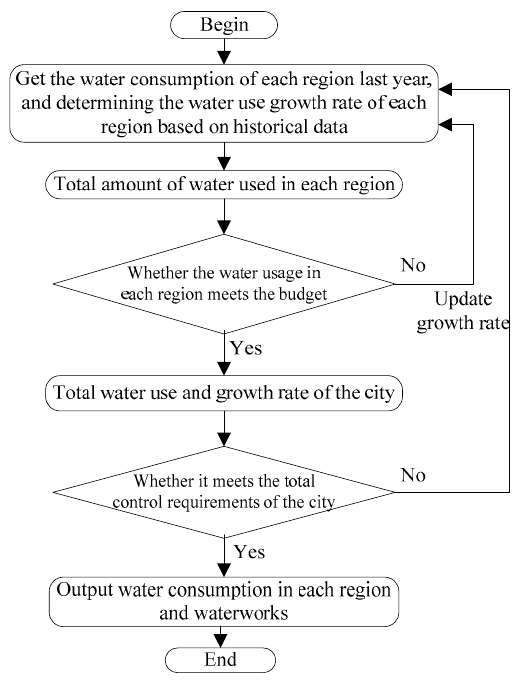
Figure 3. The water demand forecasting process of the waterworks.